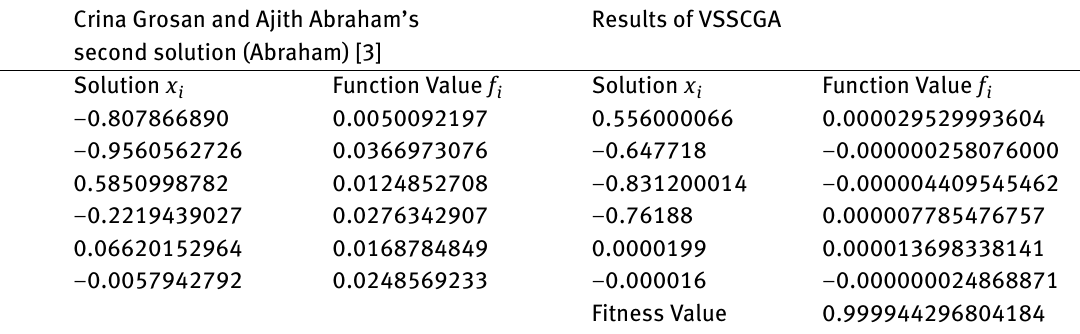
Table 36: Comparison of VSSCGA’s results with Crina Grosan and Ajith Abraham’s results for Neurophysiology Application problem (case